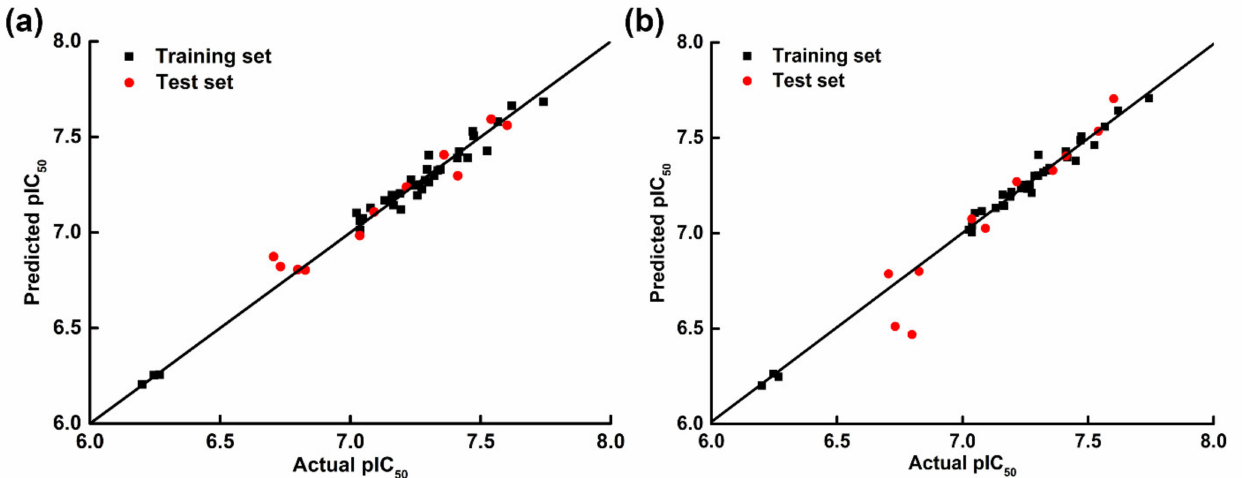
Figure 2. Scatter plots of actual versus predicted pIC 50 values for the used XOIs based on the CoMFA ( a ) and CoMSIA- SEHDA ( b )